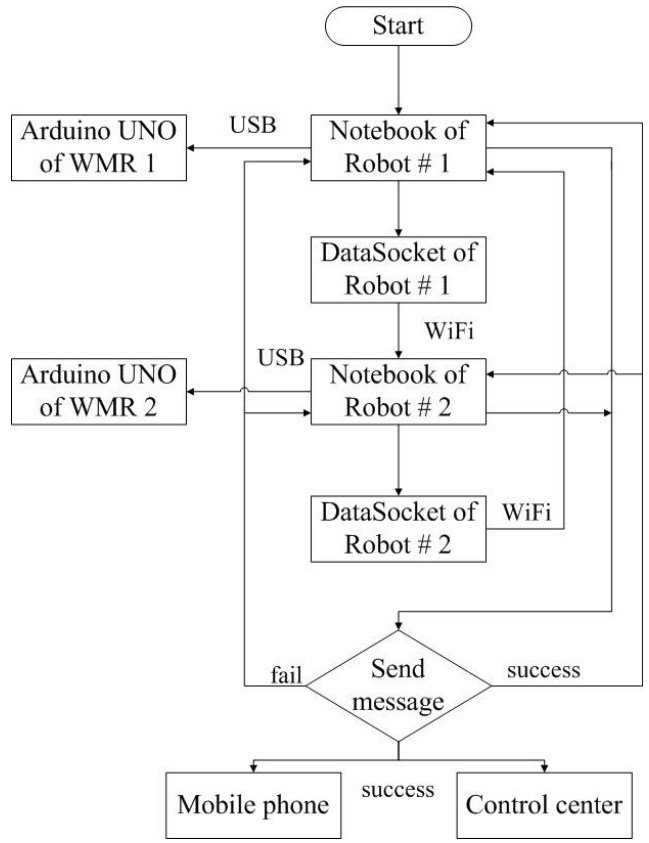
Figure 31. Communication sequence.